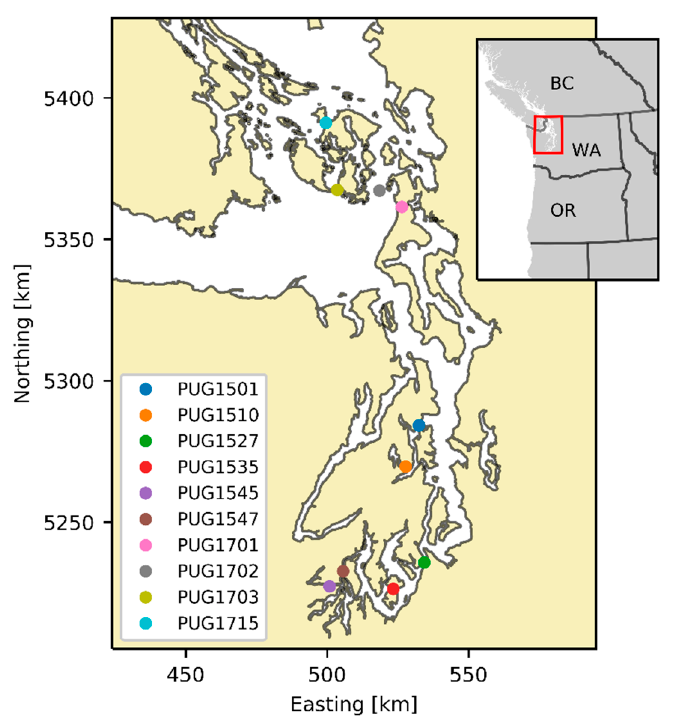
Figure A1. Ground truth stations in the Salish Sea. BC: British Columbia, Canada; WA: Washington, USA; OR: Oregon, USA.